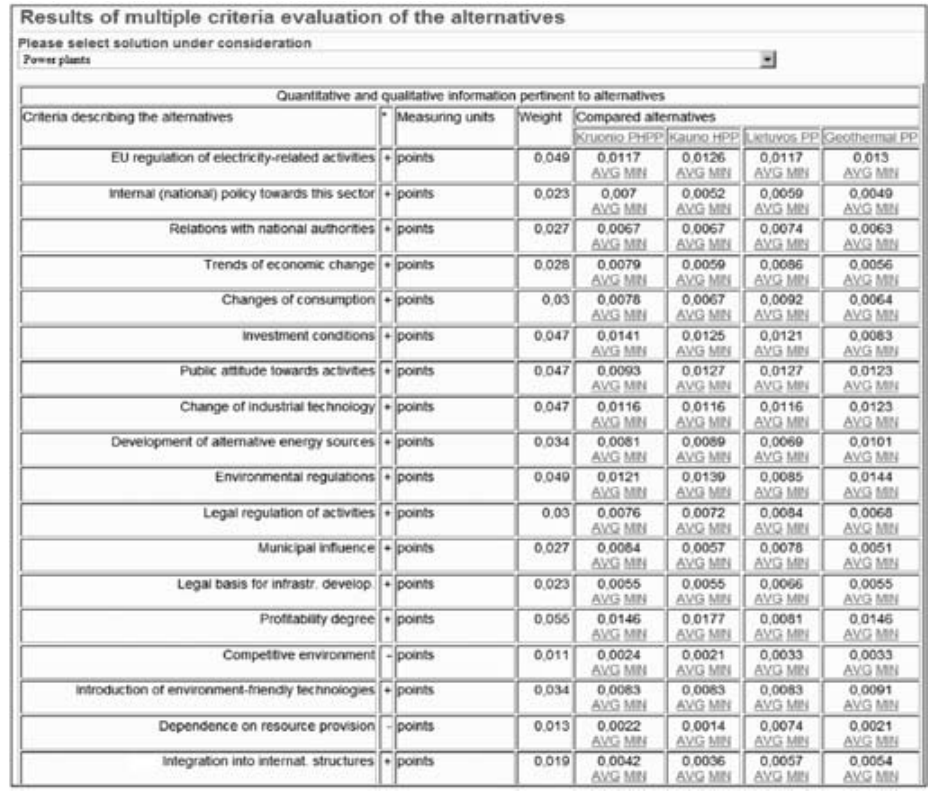
table 6. Initial data and results of multiple criteria evaluation of the